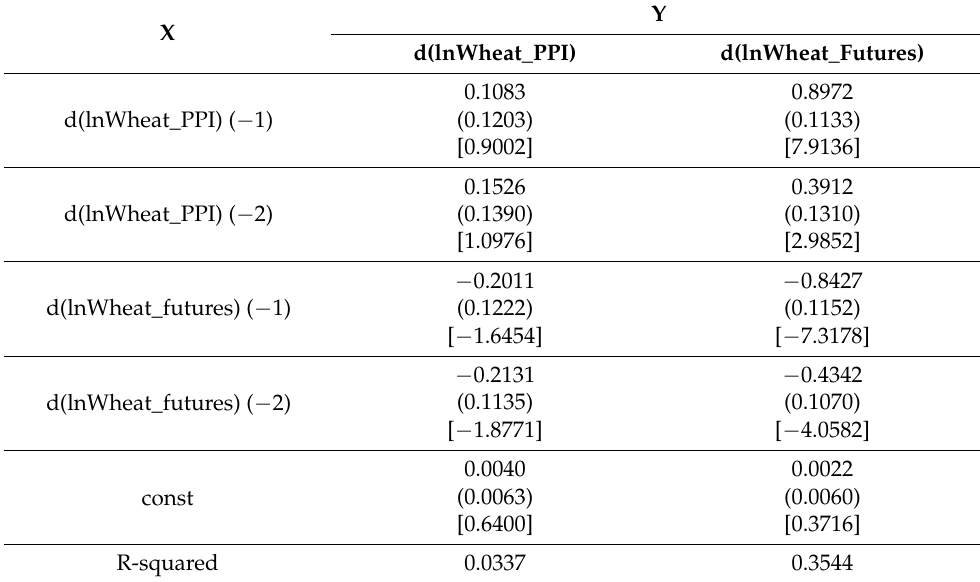
Table 4. VAR model for logarithmic cash and futures prices of wheat.